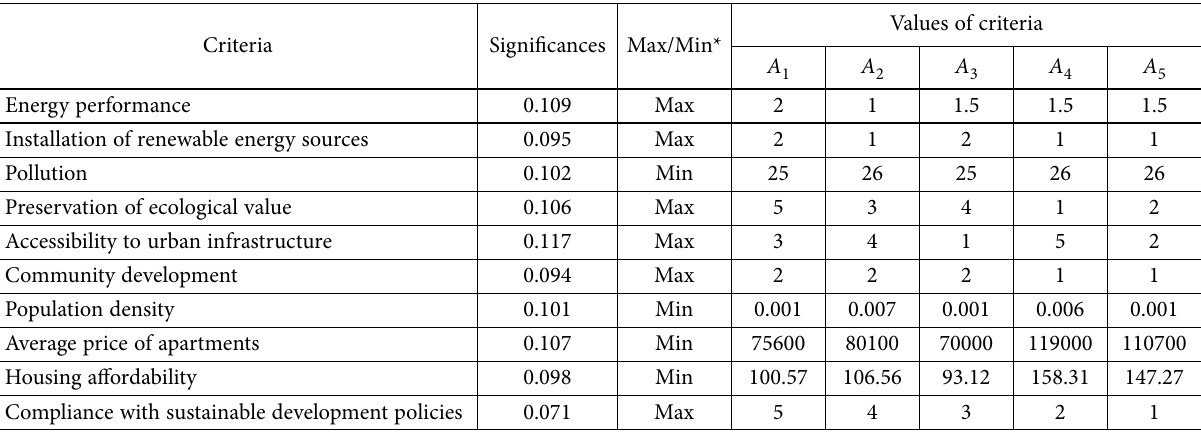
Table 3. Decision-making matrix